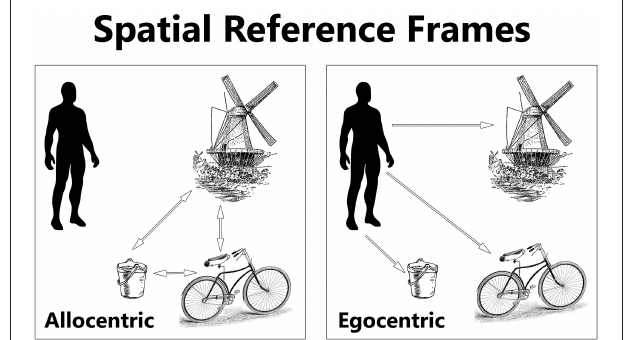
FIGURE 2 | The location of objects can be represented in egocentric and allocentric spatial reference frames. An egocentric reference frame represents objects in relation to the location of the self (the observer). An allocentric reference frame represents objects in relation to one another. Inspired by Kozhevnikov